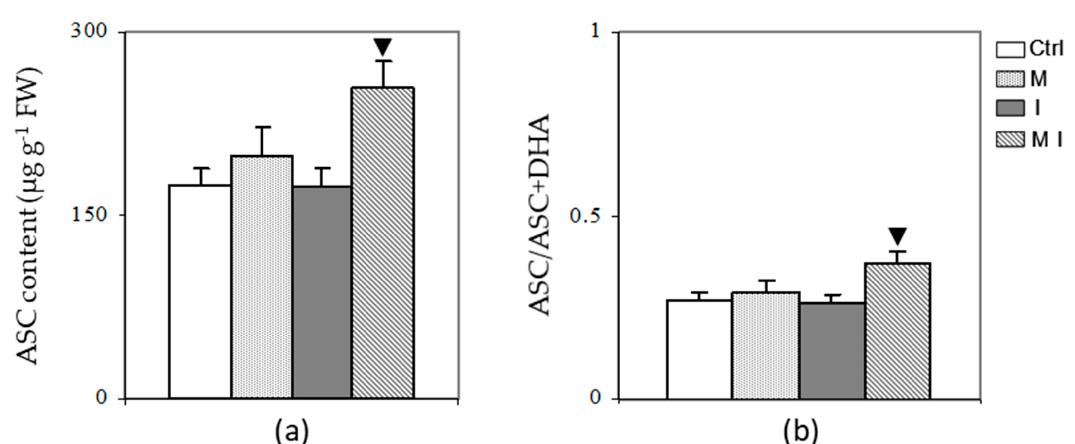
Figure 1. Ascorbate (ASC) content ( a ) and ASC redox ratio ( b ) in artichoke control plants (Ctrl), in mycorrhizal plants (M), in plants inoculated with Verticillium dahliae (I), and in mycorrhizal plants inoculated with V. dahliae (MI). The results are given as the mean values of at least five experiments ± SD; ▼ indicates values significantly different from the artichoke inoculated with V. dahliae (I) by the Student’s t test with p < 0.05. FW, fresh weight.